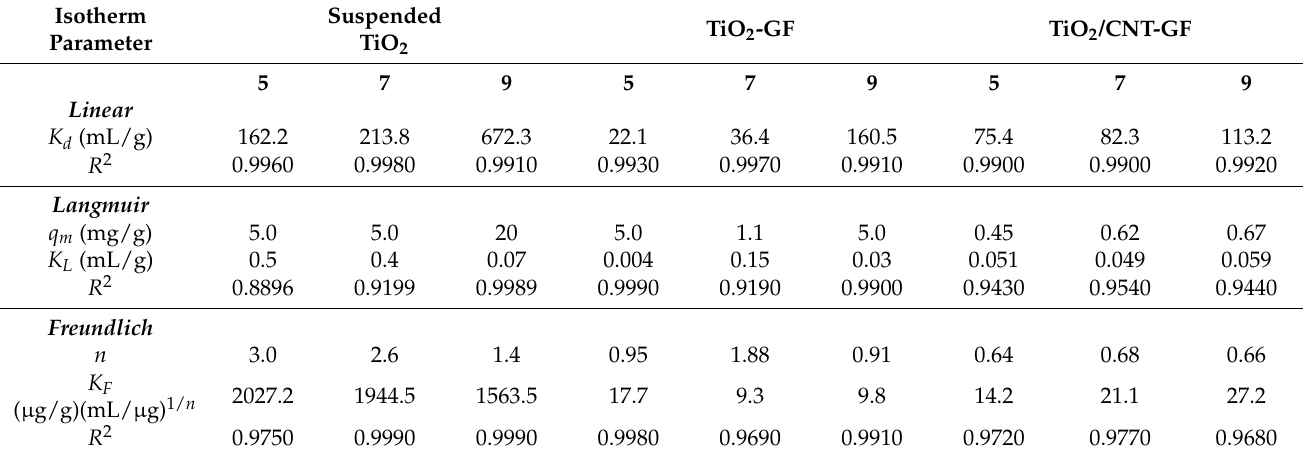
Table 6. Sorption isotherm parameters for IMT as an influence of pH.